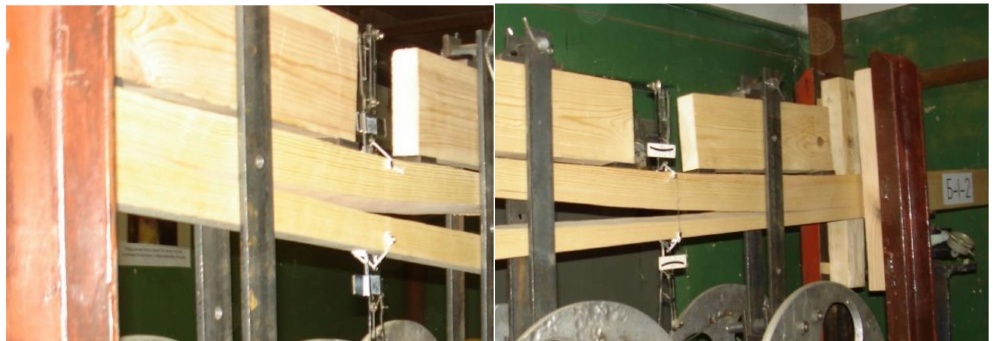
Figure 6. Characteristic fracture of unreinforced beams during their failure.